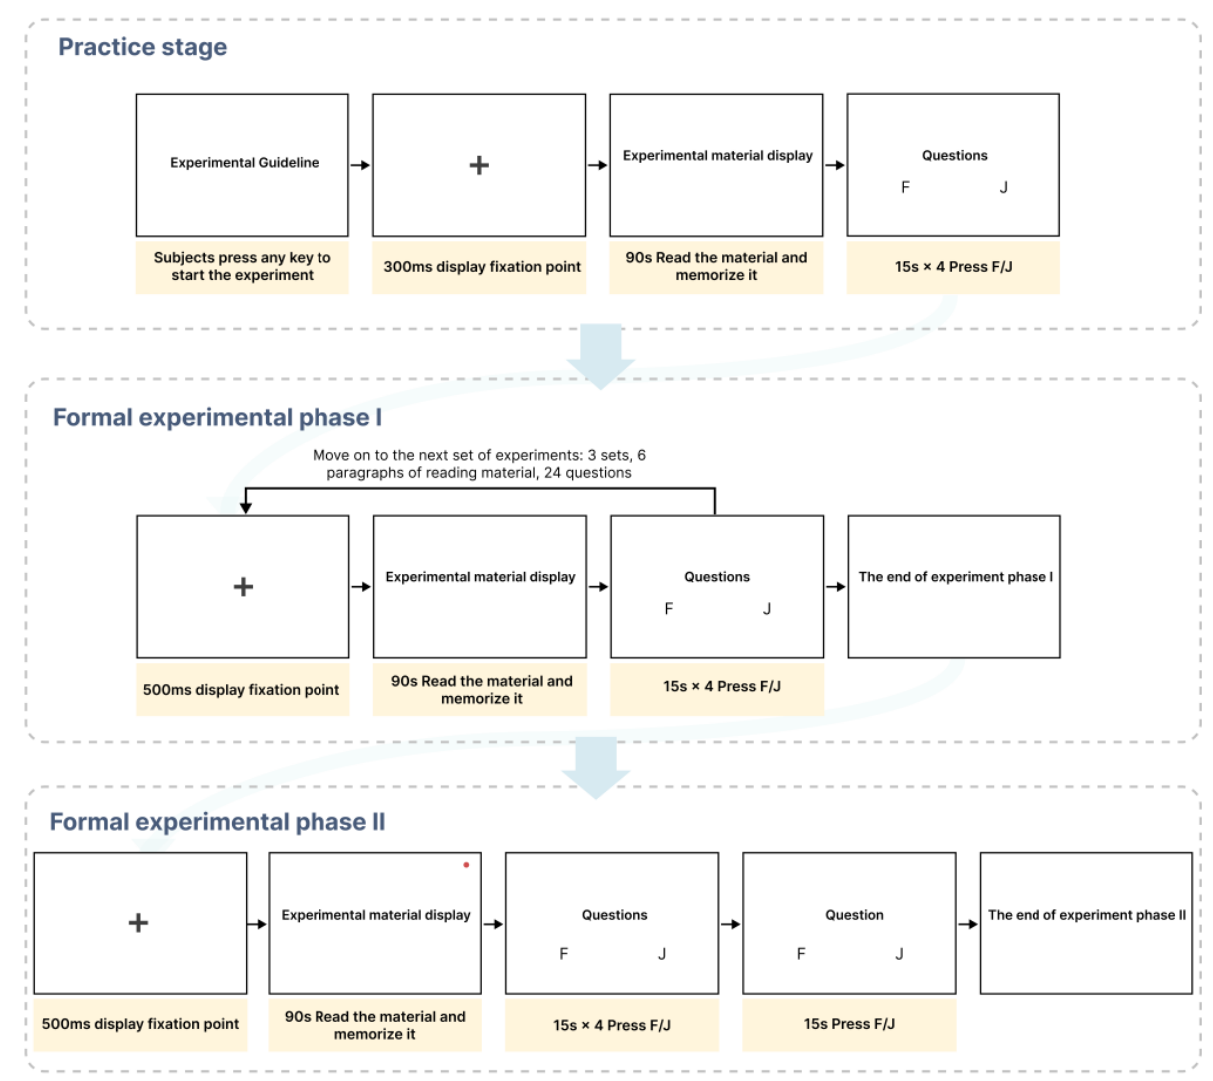
Figure 8. Experimental flow chart.